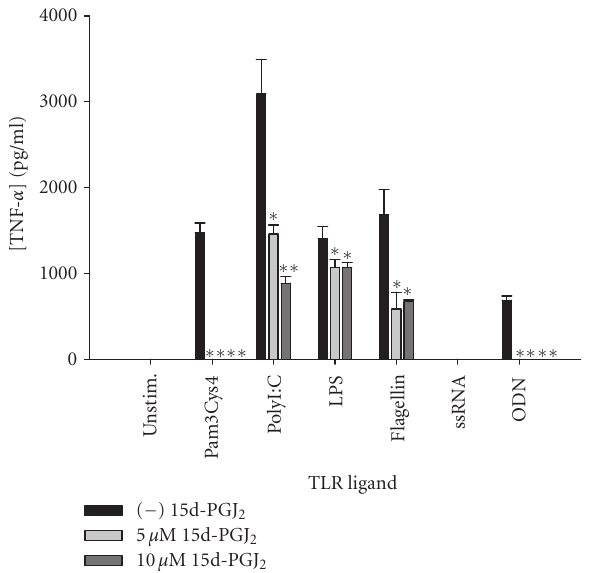
Figure 5: The synthetic PPAR- γ agonist rosiglitazone selectively inhibits microglial TNF- α expression in response to TLR ligands. Primary microglia were plated at 2 × 10 5 cells/well in 96-well plates and incubated overnight. The following day, cells were pretreated for 1hour with the indicated concentrations of rosiglitazone prior to the addition of TLR ligands. Cell-conditioned supernatants were collected at 24hours following TLR ligand exposure, whereupon TNF- α levels were determined by ELISA. Significant di ff erences between microglia treated with TLR ligands alone versus TLR ligands + rosiglitazone are noted with asterisks ( ∗ P < . 05). Results presented are representative of two independent